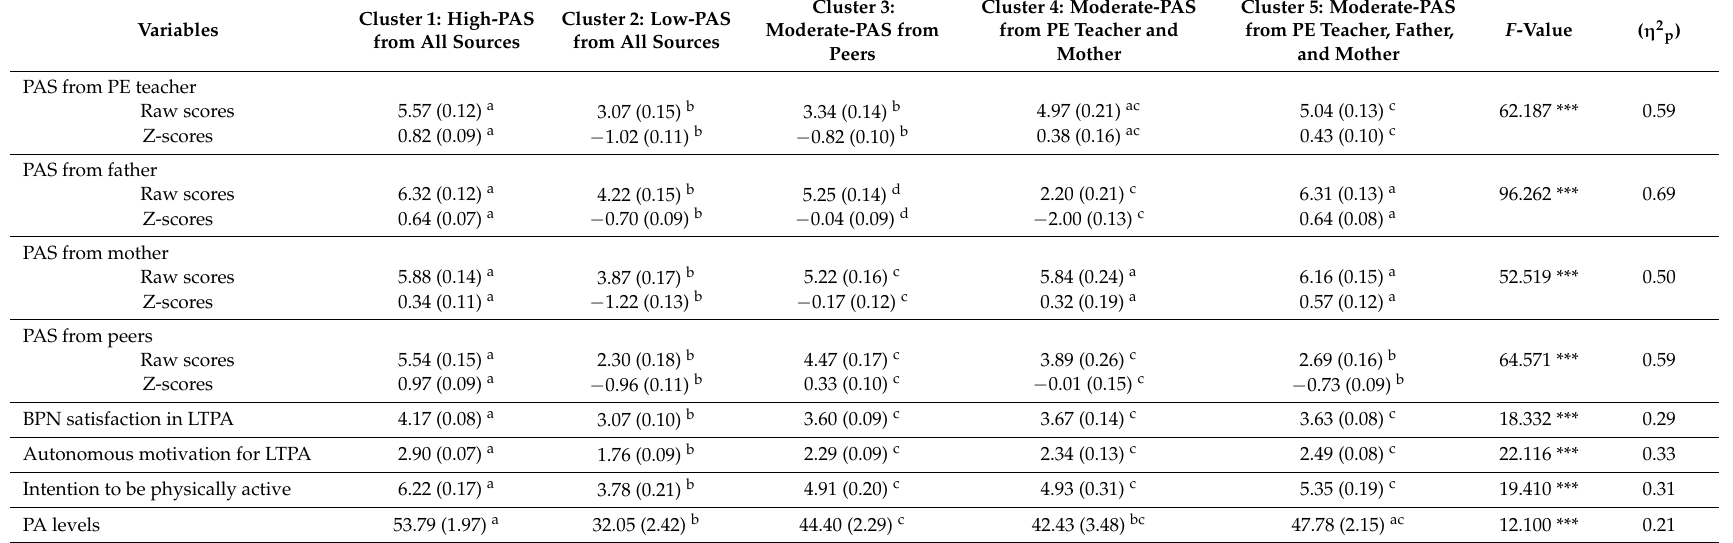
Table 4. Mean differences in motivational outcomes in a LTPA context and PA levels according to cluster